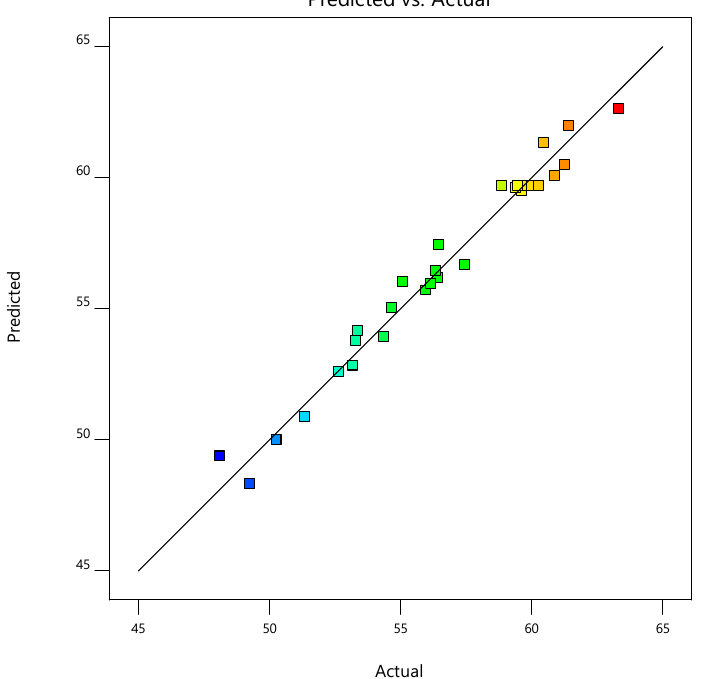
Figure 6. The relationship between the predicted and actual values for the Box-Behnken design, R 2 = 0.9762.